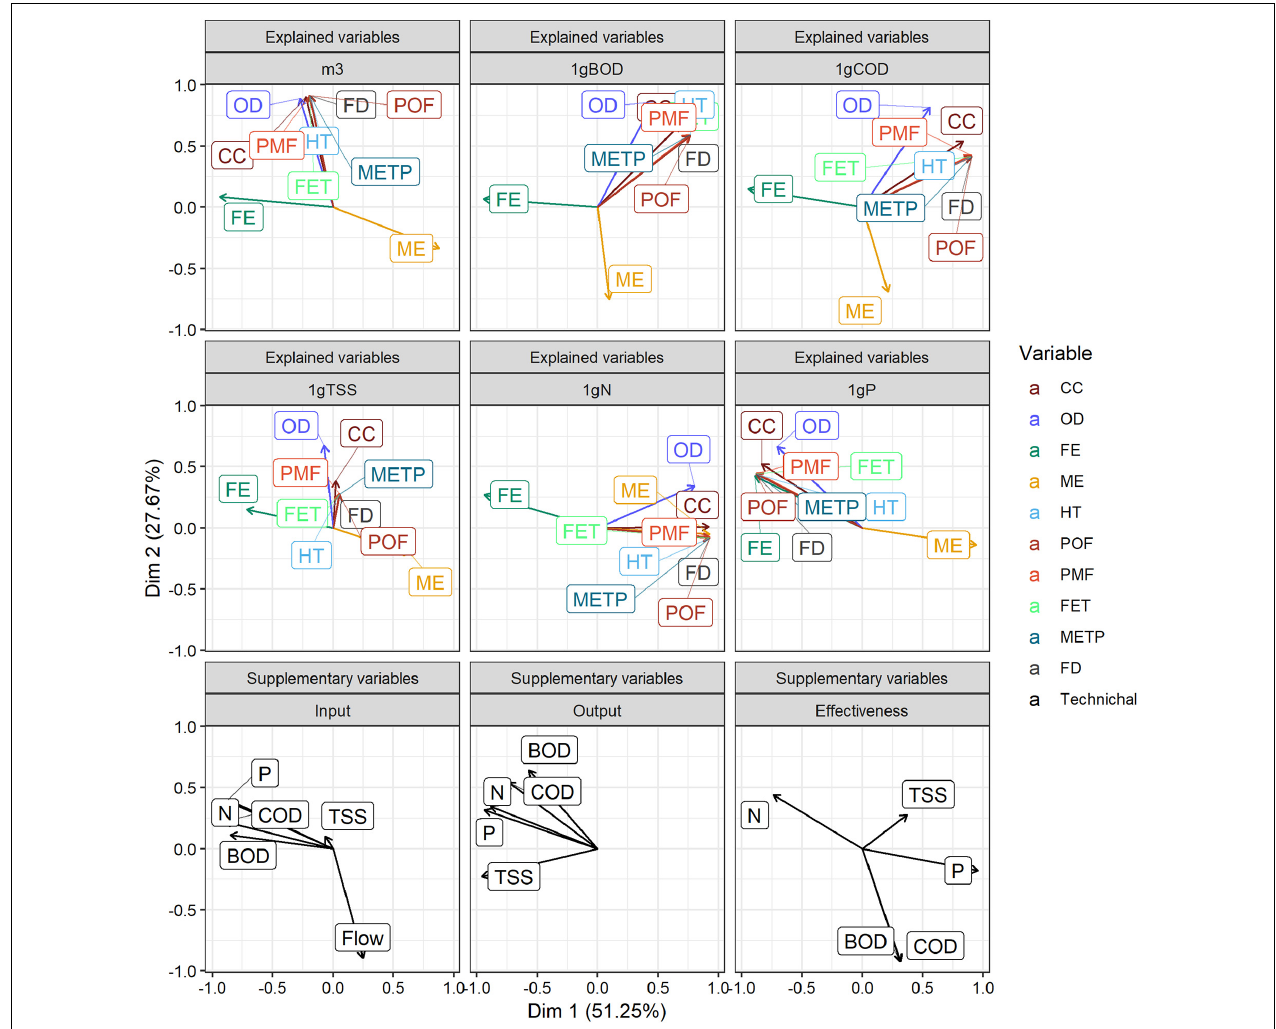
FIGURE 9 | Results of PCA analysis for the results depending on the selected FU, category, and related to the technical